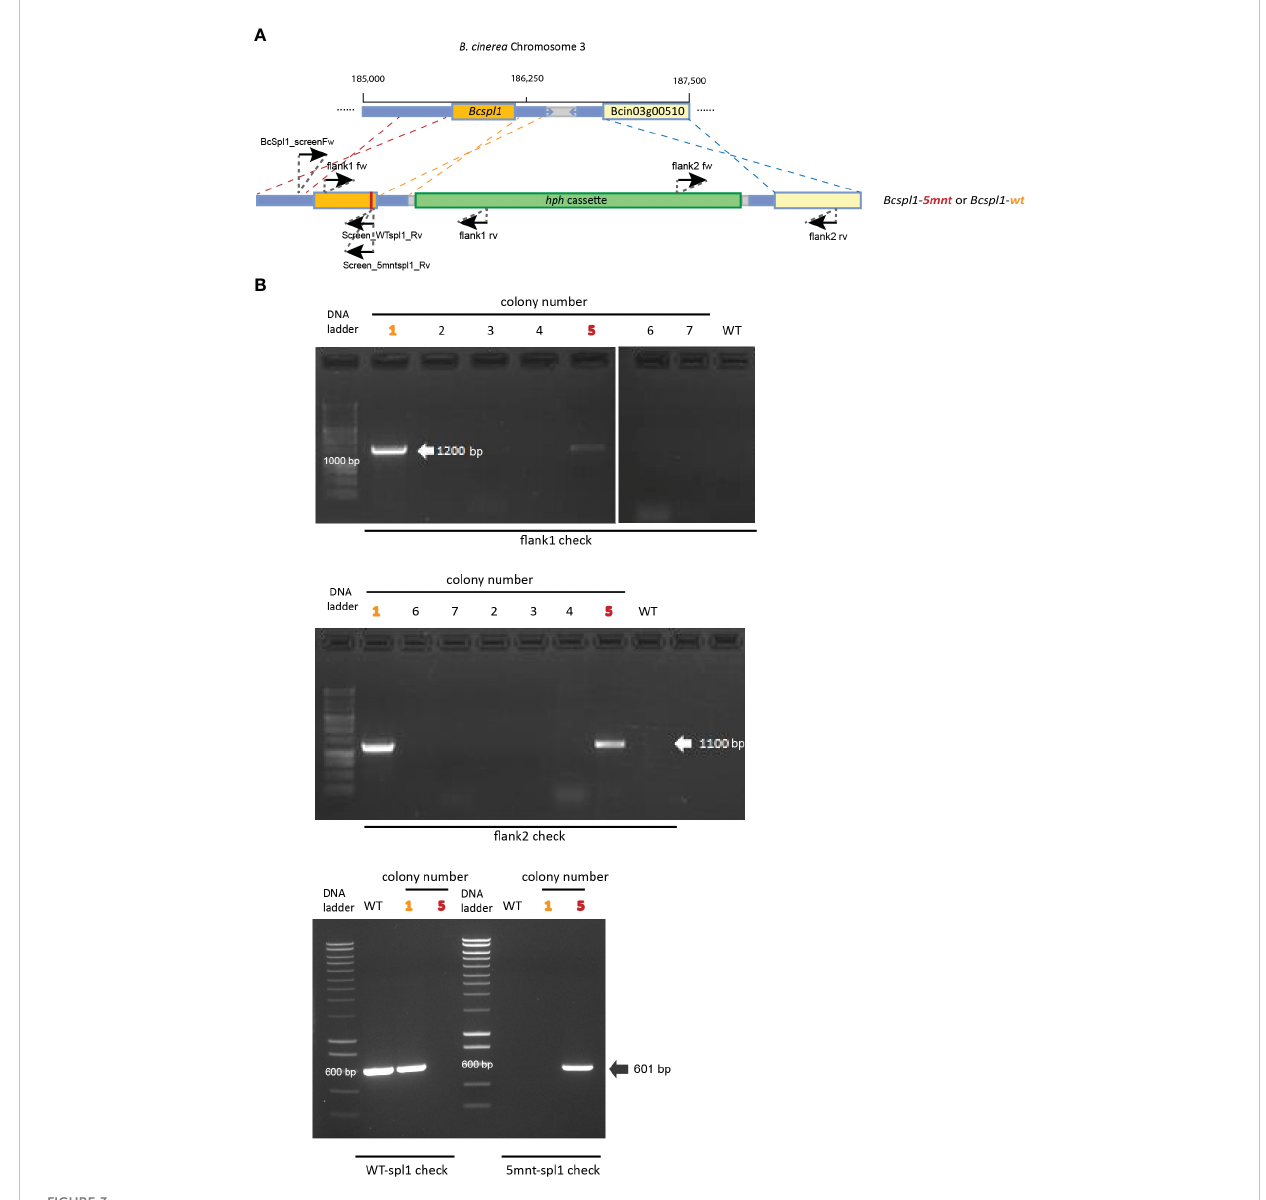
FIGURE 3 (A) Schematic representation of recombination events resulting in the generation of the transformants spl1-5mnt (red dashed lines) or spl1-wt (orange dashed lines). The blue dashed lines indicate the 3 ’ -recombination event. The positions of primers used in genotyping the transformants